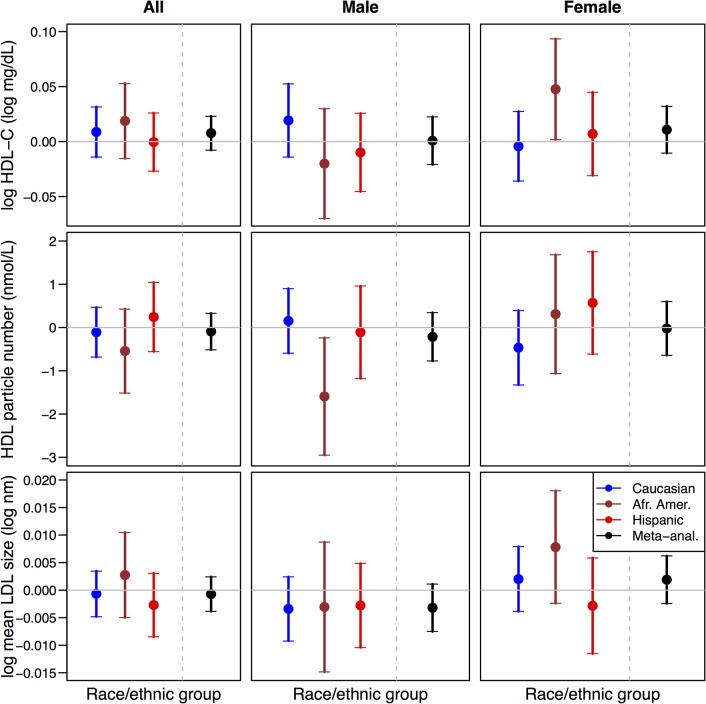
Summary of genetic additive effects of rs4238001 allele T on HDL-C (log mg/dL), HDL particle number (nmol/L) and HDL particle size (log nm) under a basic model (Model 1).Analyses were conducted stratified by race/ethnic group and combined by meta-analysis, for all participants as well as stratified by sex (males or female).